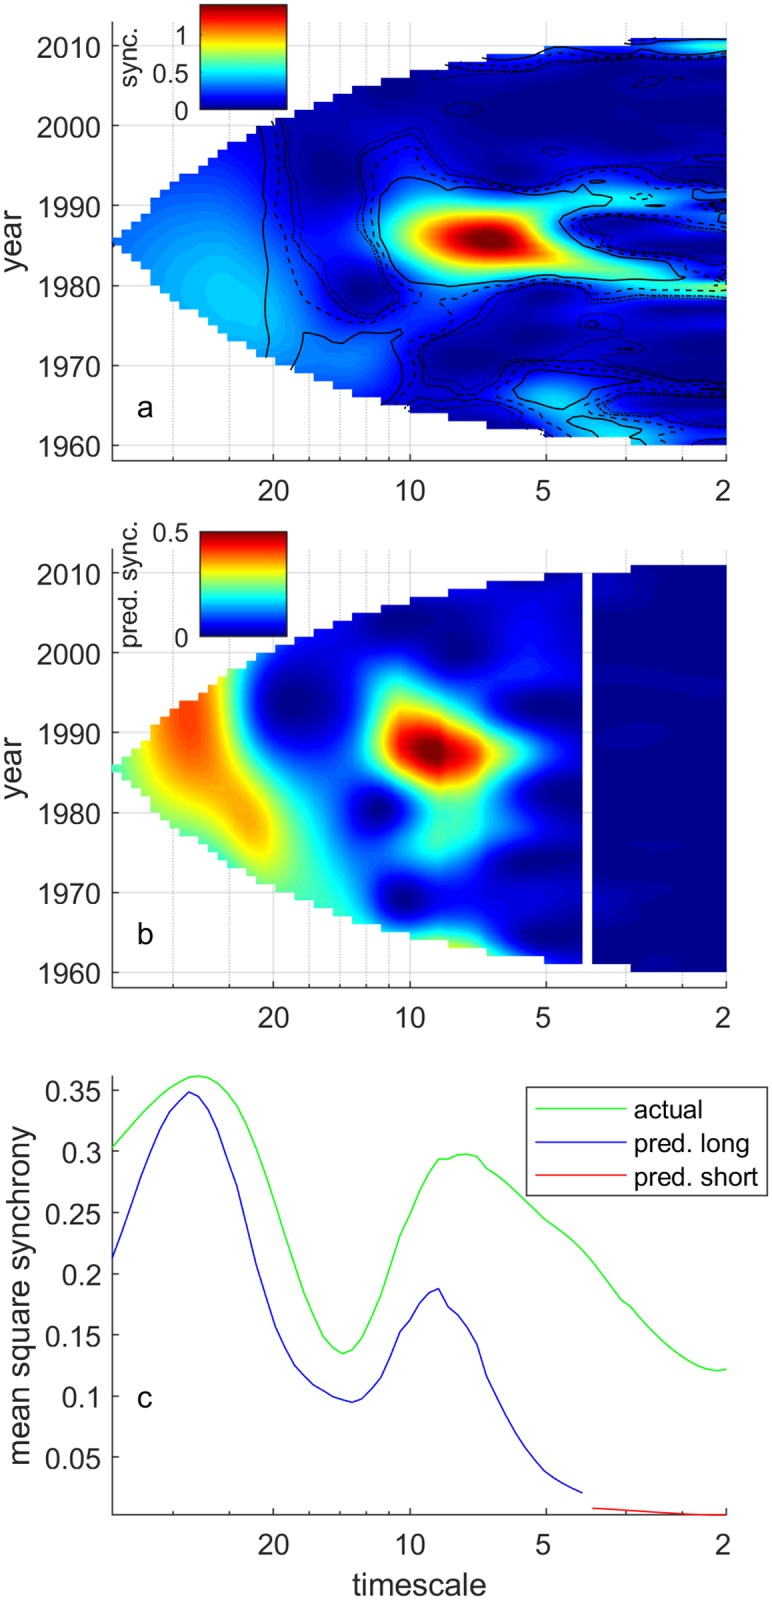
Our best long-timescale model explained synchrony on long timescales, but our short-timescale model did not explain synchrony on short timescales.The PCI squared WMFM plot (a, colors) showed that spatially synchronous fluctuations in PCI occurred at different time points within the time series for different frequencies. Contours indicate statistically significant phase synchrony (at the 0.1, 0.05, 0.01, and 0.001 levels, respectively for the different contours) and are taken from the WPMFM plot (Methods; S2 Fig). Synchrony predicted (Methods) by the best long-timescale wavelet model (b, left of white line) resembled real patterns of synchrony, but synchrony predicted by the best short-timescale model (b, right of white line) did not. Mean squared WMFM (c, green line; Methods) was moderately well approximated by the mean squared value of predicted synchrony for long timescales (c, blue line) but not for short timescales (c, red line). Sync. = synchrony; pred. = predicted.